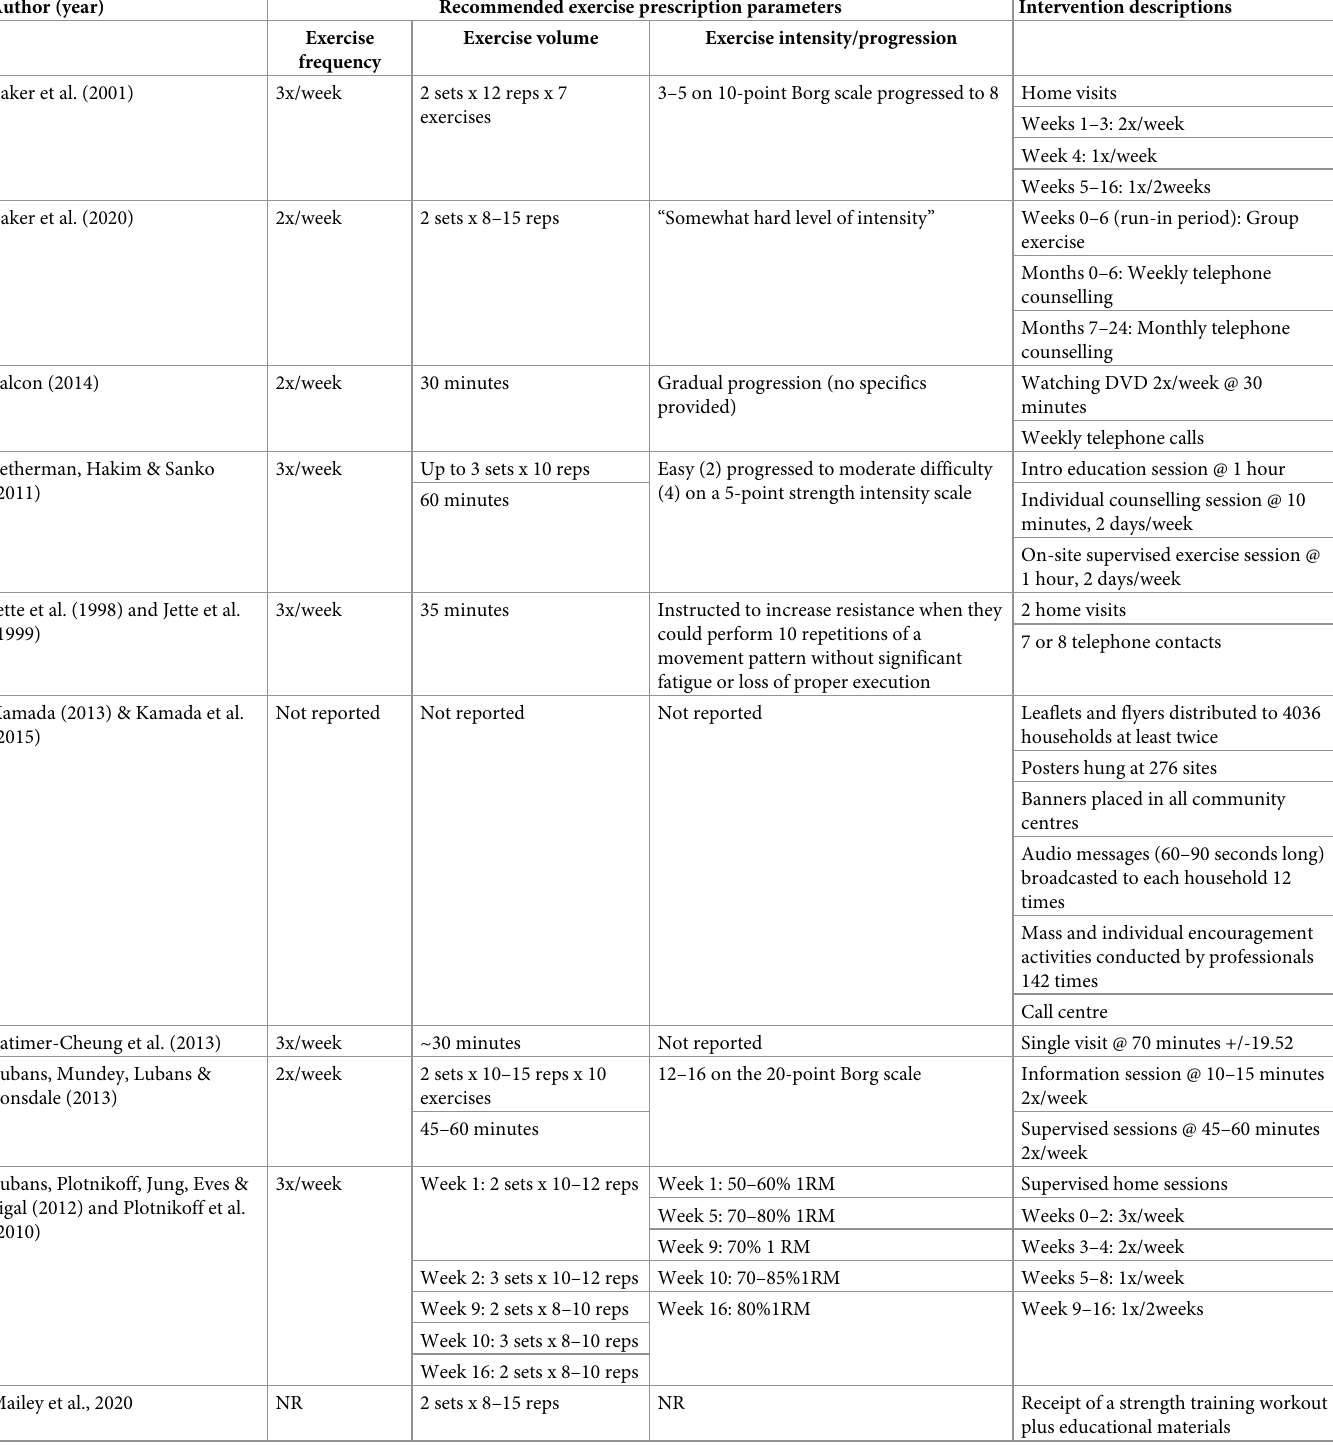
Table 3. Recommended exercise prescription parameters and intervention